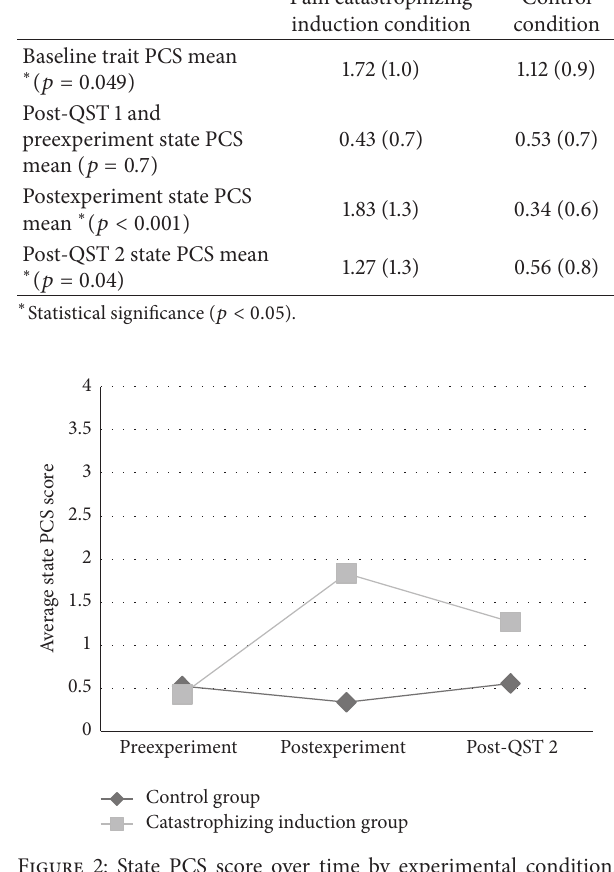
Figure 2: State PCS score over time by experimental condition. There was a significant interaction of time and condition on state PCS controlling for baseline trait PCS and baseline current back pain intensity (unstandardized 𝛽 = − 0.39, 𝑝 = 0.02 ), with significantly larger increases in PCS scores after the experiment in the pain catastrophizing induction condition compared to the control condition.